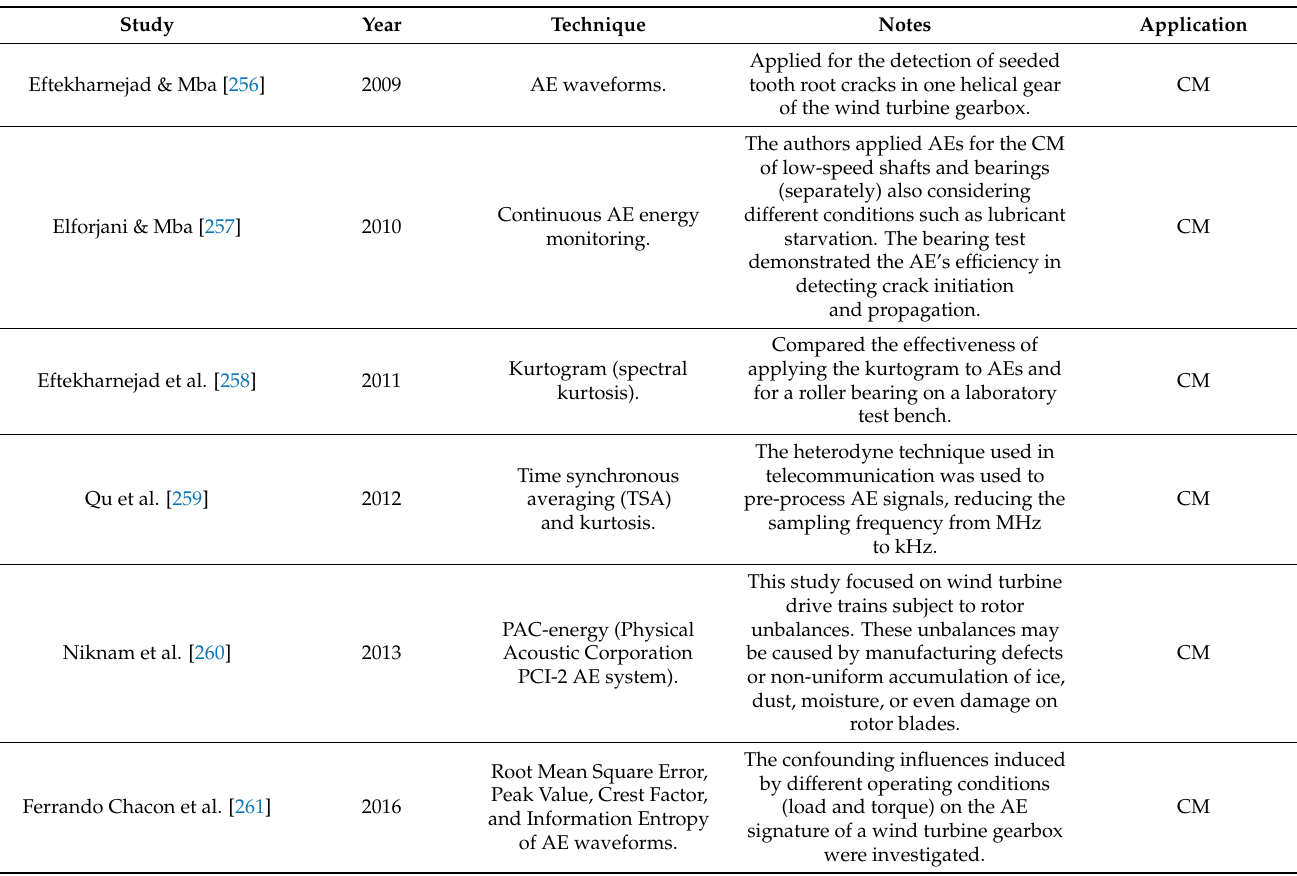
Table 8. Some notable and recent examples of AE techniques applied for the NDE of wind